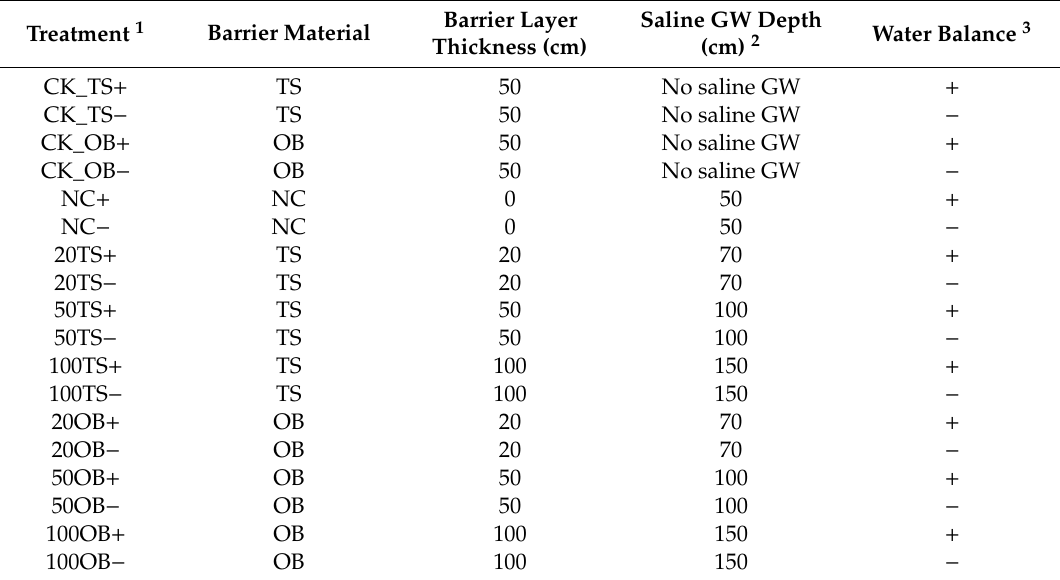
Table 2. A list of treatment codes and details of the